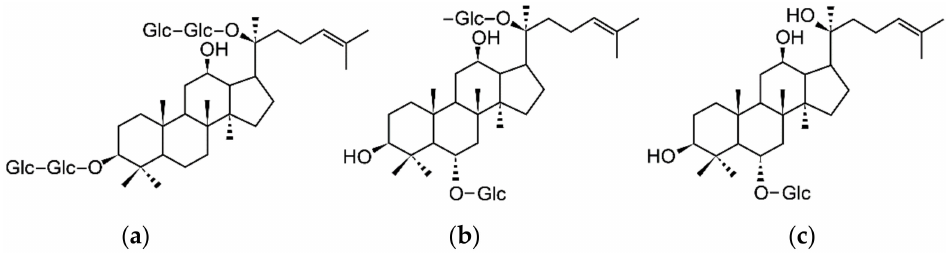
Figure 6. The chemical structures of ( a ) ginsenoside-Rb1, ( b ) ginsenoside-Rg1, and ( c ) ginsenoside-Rh1. Reprinted from Jo J.J.; Shrestha R.; Lee S. Inhibitory Effects of 12 Ginsenosides on the Activities of Seven Cytochromes P450 in Human